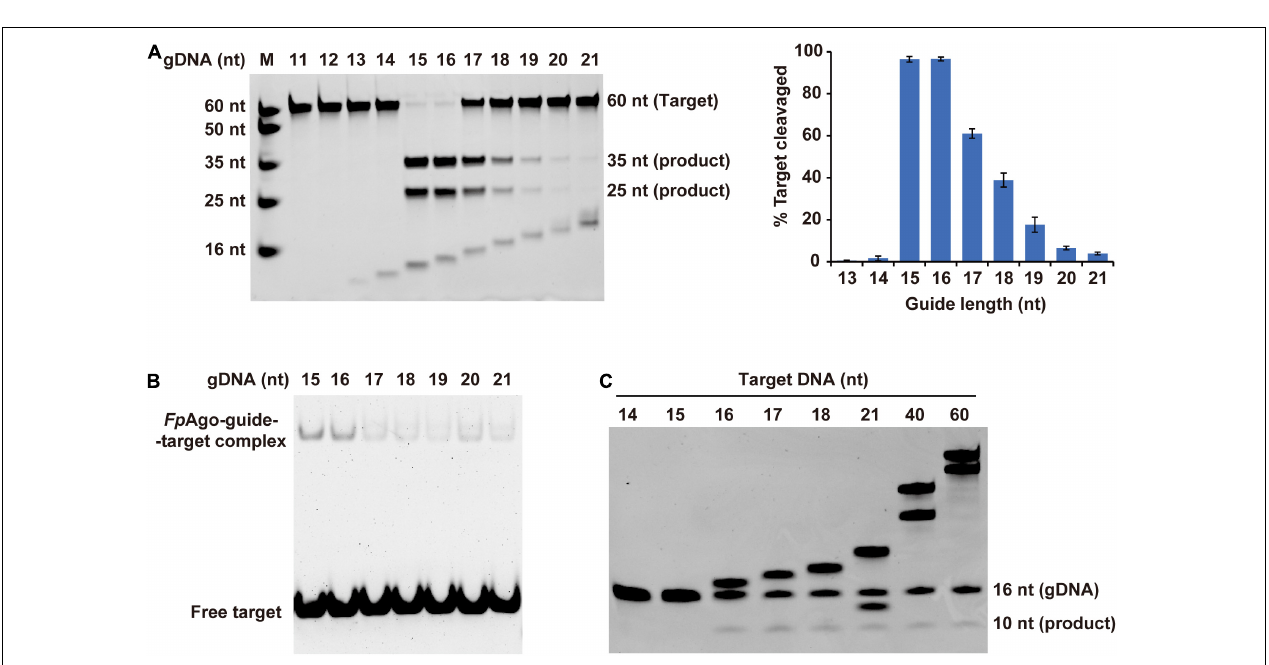
FIGURE 3 | Effects of 5 (cid:48) -end nucleotides and modifications of gDNA on cleavage activity. (A) Cleavage kinetics of ssDNA target using 5 (cid:48) -P guided Fp Ago. Error bars represent the standard deviation of three independent experiments. (B) Effects of 5 (cid:48) -end modification of gDNA on Fp Ago cleavage activity.